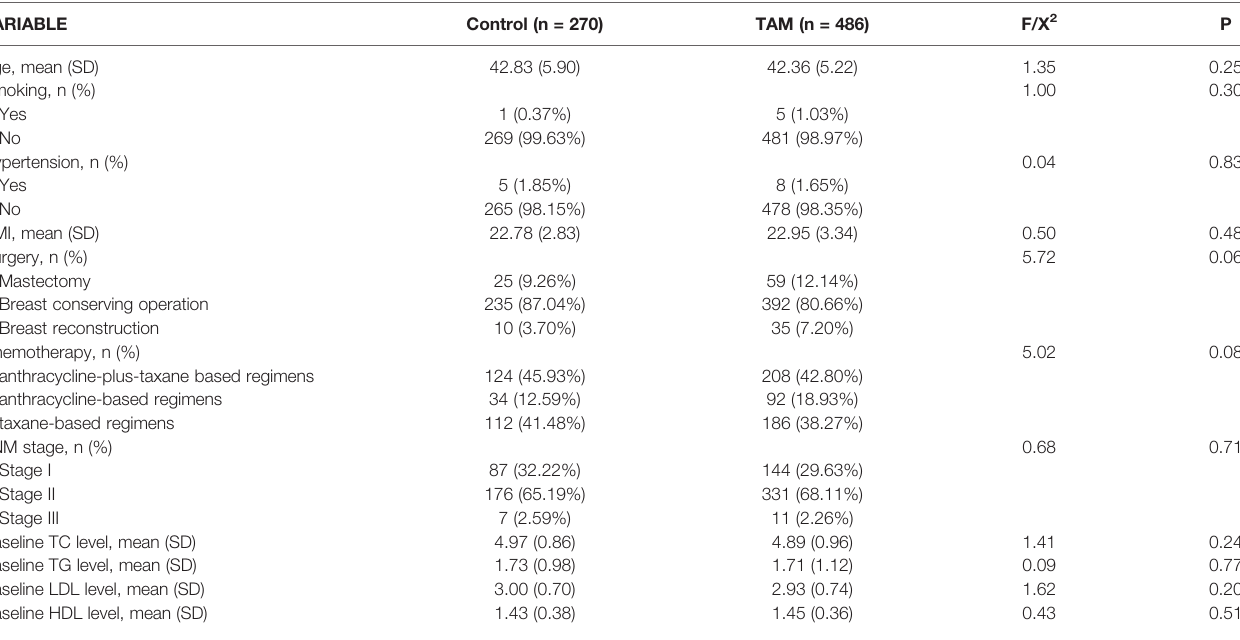
TABLE 1 | Baseline characteristics of premenopausal breast cancer